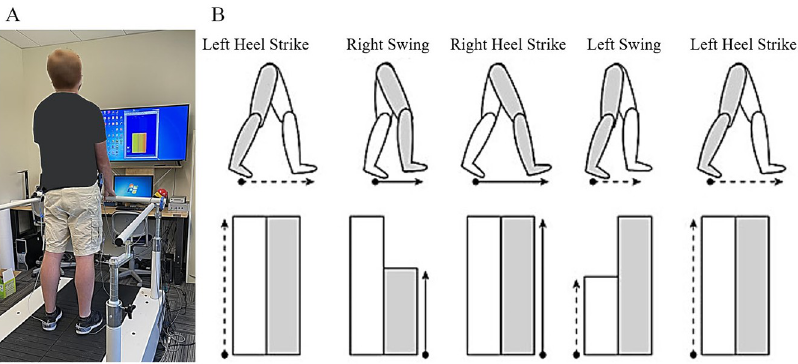
Fig 1. Experimental setup showing an instrumented treadmill and visual feedback. A : Three infrared cameras were placed behind to capture the two markers attached to the subjects’ shoes. B : Visual representation of subjects’ movement was captured using a motion capture system. The range of the right and left step lengths was mapped to the vertical bars. During the swing phase of a leg, the corresponding bar increases proportional to the step length and stops when a heel strike occurs for that leg. For visual distortion, the range of right step length mapped to the visual bar was gradually distorted.